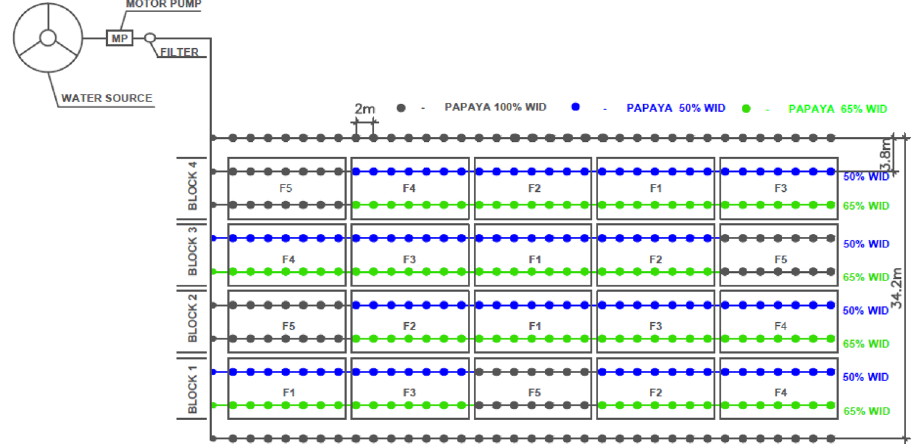
Figure 3. Treatments in the field conditions: F1—plant row side-shifting-frequency of 7 days, F2—plant row side-shifting-frequency of 14 days, F3—plant row side-shifting-frequency of 21 days, F4—only one plant-row side irrigated and F5—Both plant-row sides irrigated (100% WID).